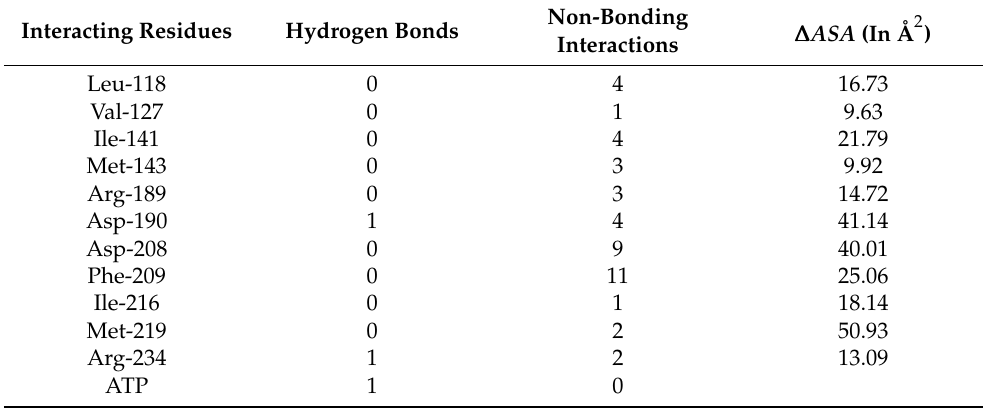
Table 6. The MEK1 residues interacting with selected flavonoid (CID: 10575055) are listed with the number of non-bonding interactions and ∆ ASA